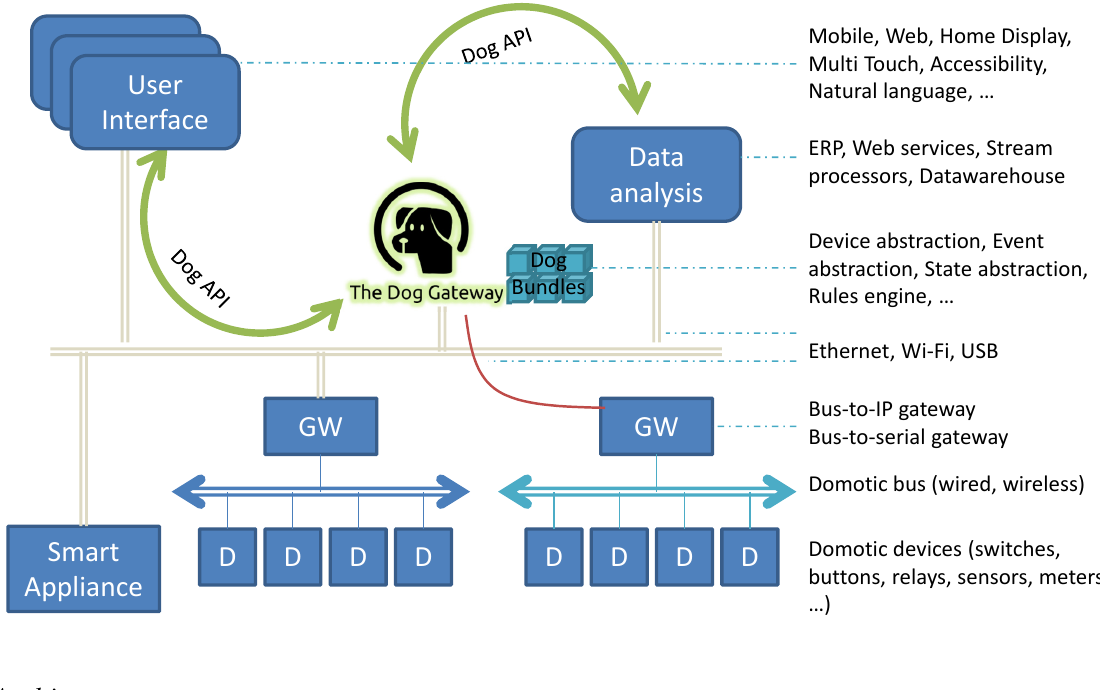
Figure 6. Using the Dog Gateway as a middleware